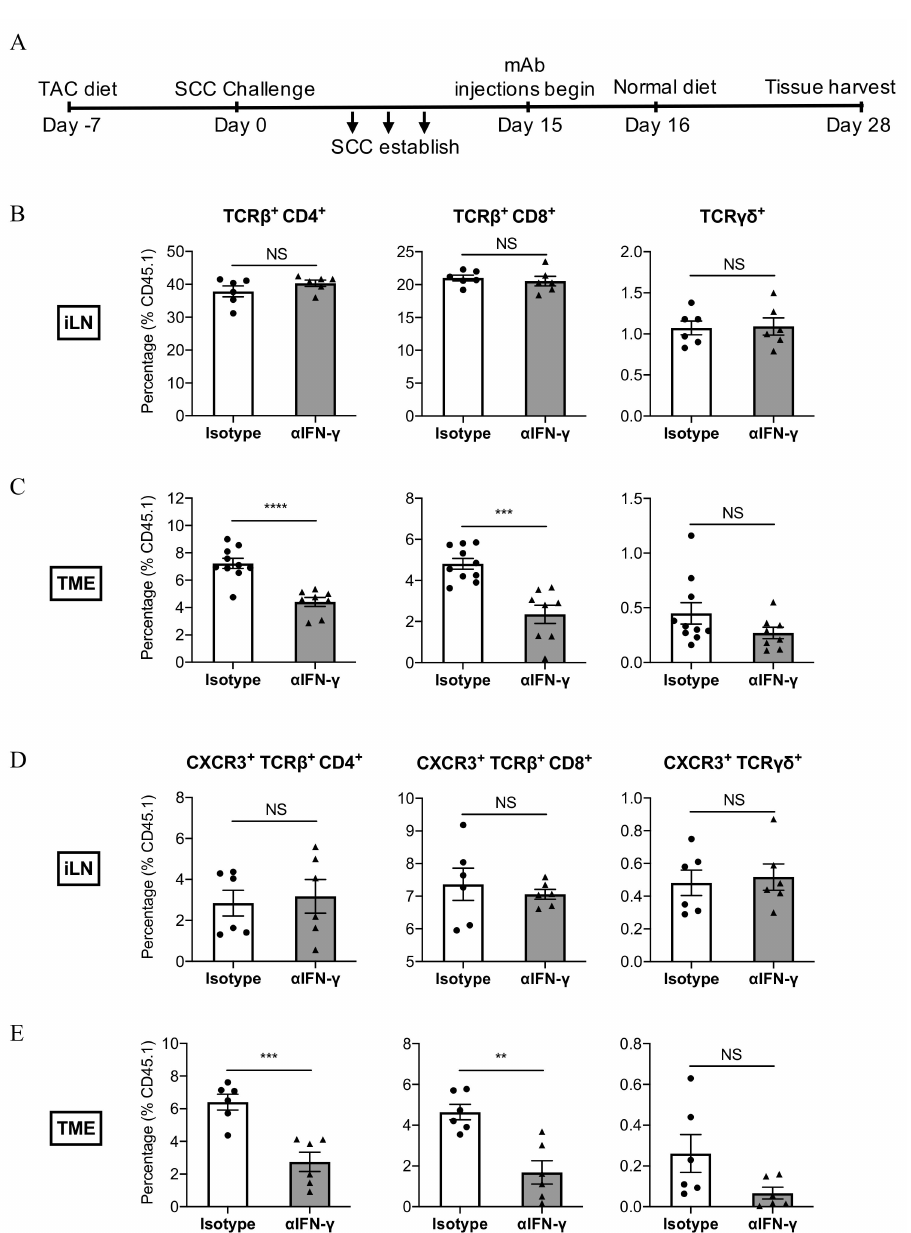
Figure 5. IFN- γ neutralisation reduces the number of CD8 + T cells that infiltrate into SCC. ( A ) Ex- perimental schedule. ( B , C ) Abundance of T cell subsets, and ( D , E ) abundance of CXCR3-expressing T cell subsets in the inguinal lymph nodes (iLN) or tumour microenvironment (TME) respectively. Indicated antibody treatments started on day 15 and continued up to the point of tissue harvest. Each dot corresponds to one mouse, bars represent the mean ± SEM. ( B – E ) Data are derived